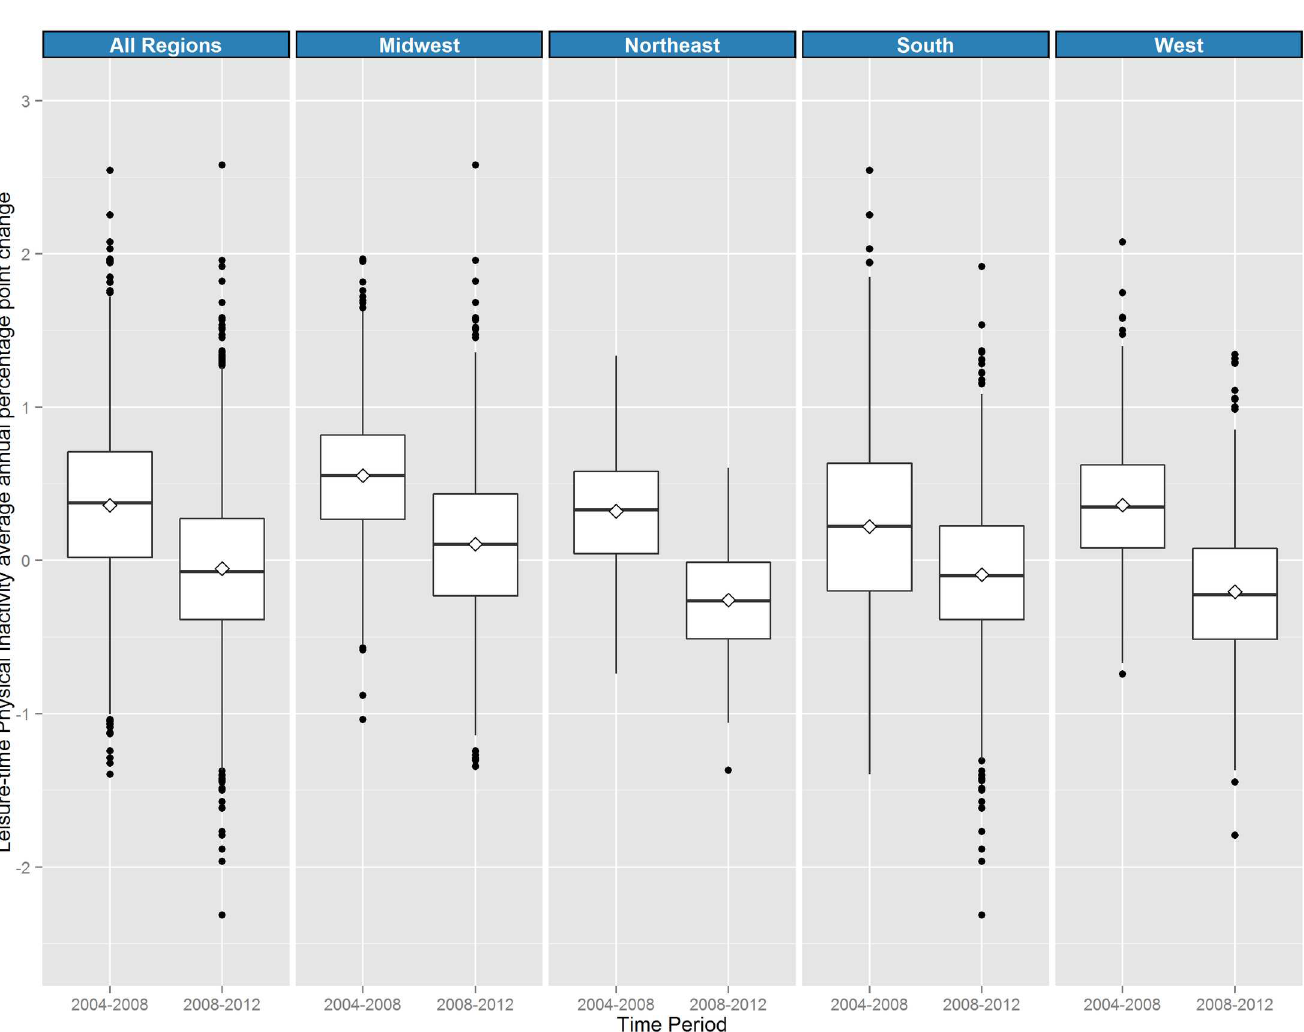
Fig 4. Distribution of county averageAnnual Percentage Point Change (APPC) in physical inactivity prevalence, by Census region, 2004–2008 and 2008–2012. Northeast regionincludesConnecticut, Maine, Massachusetts, New Hampshire,New Jersey, New York, RhodeIsland, Vermont,